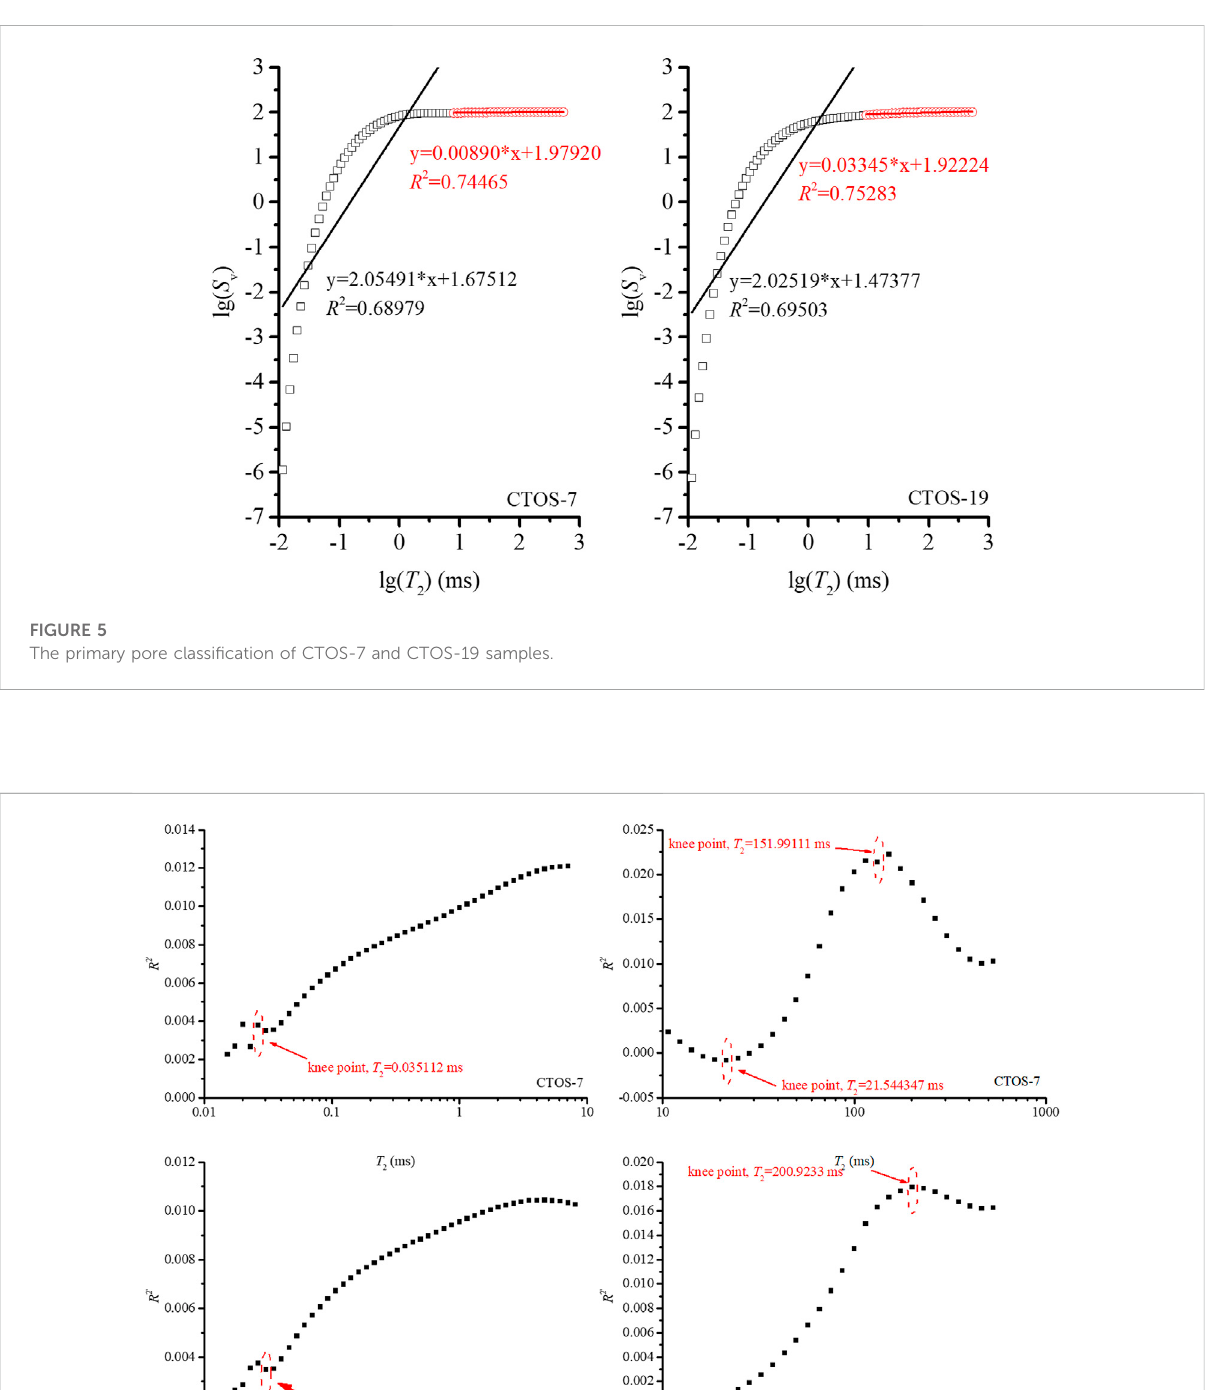
Frontiers in Earth